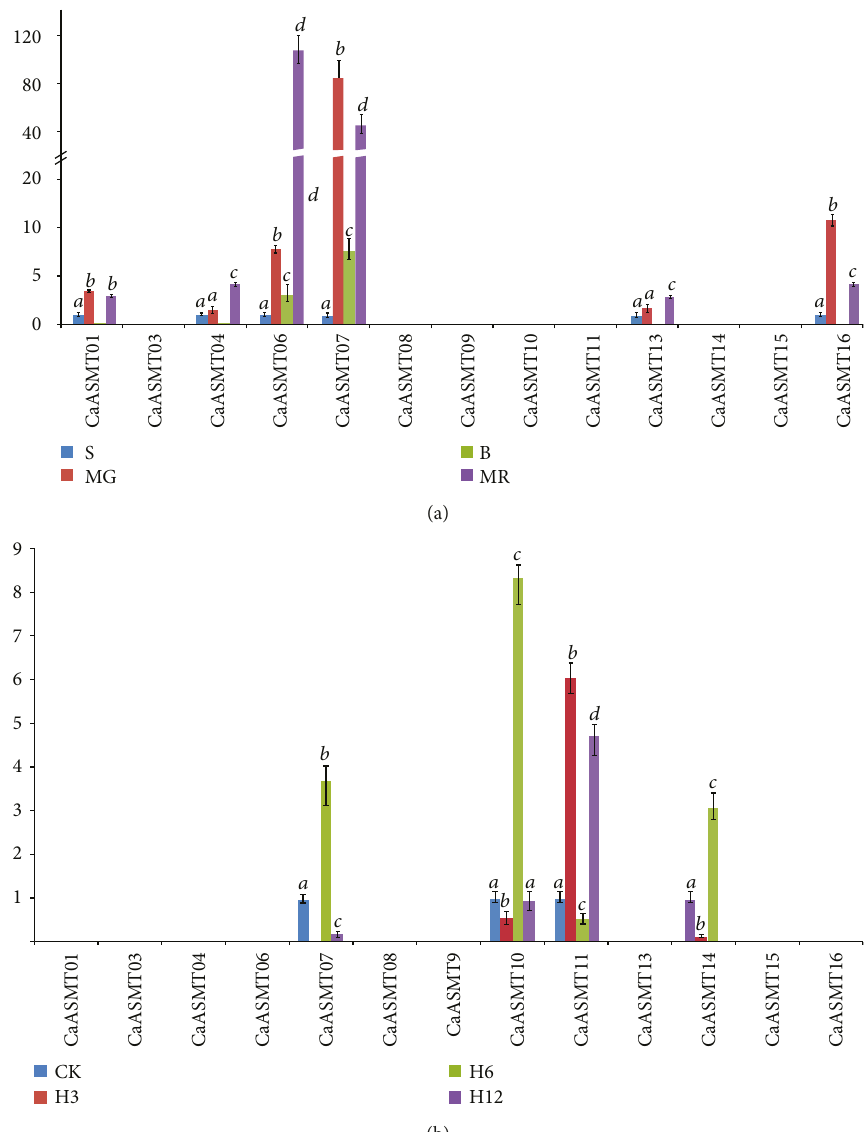
Figure 6: Expression pro fi les of CaASMT genes in di ff erent pepper tissues based on RT-qPCR. (a) Expression pro fi les of CaASMT genes in fruit. The tested tissues: small fruit (S), mature green fruit (MG), breaker fruit (b), and mature red fruit (MR). (b) Expression pro fi les of CaASMT genes under heat